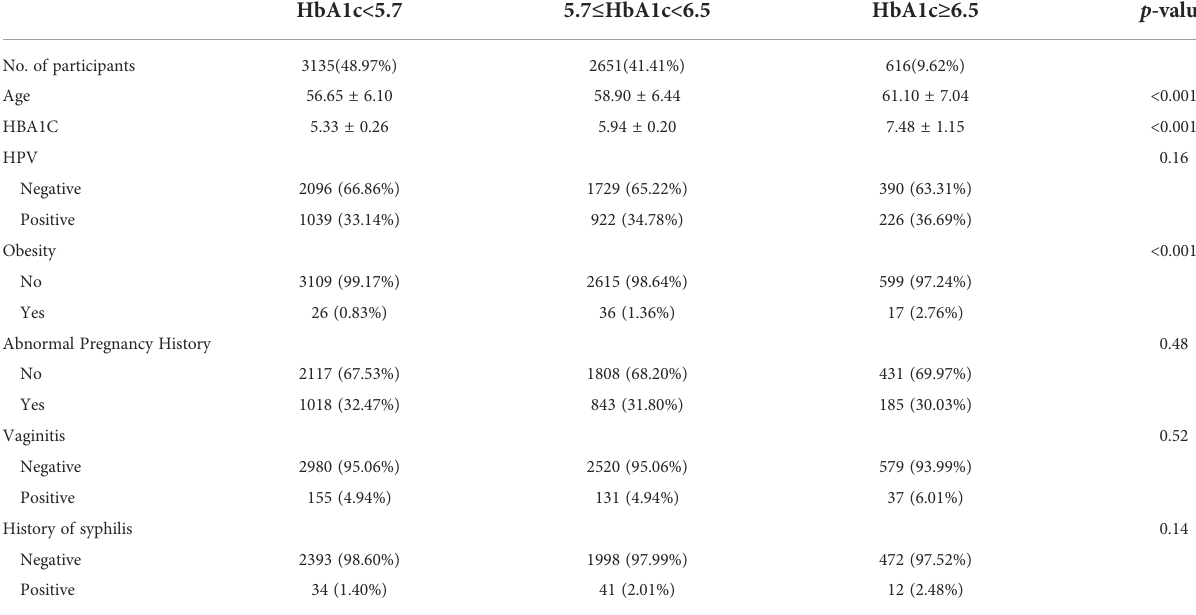
TABLE 1 Baseline characteristics of the study